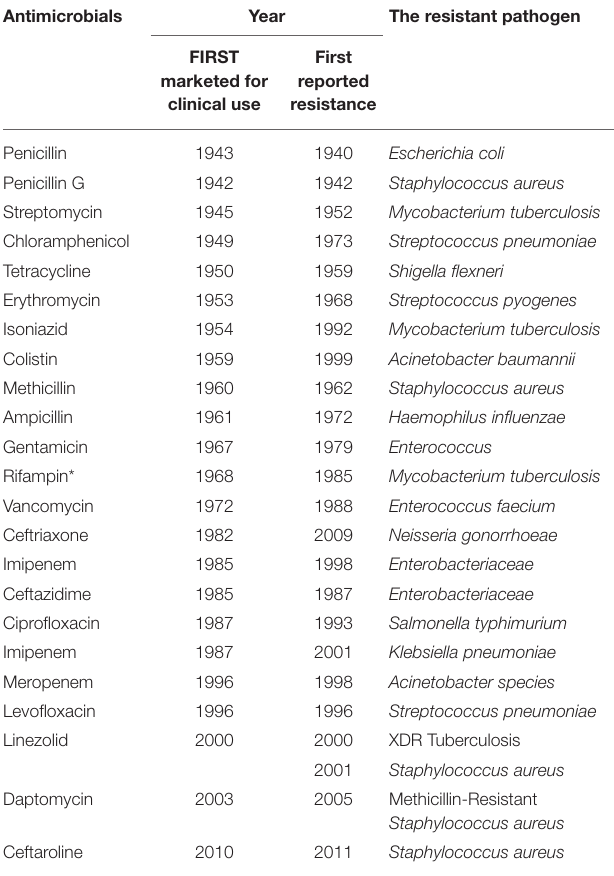
TABLE 2 | Timeline of antimicrobials development and resistance (81, 130–132, 188–210). Antimicrobials